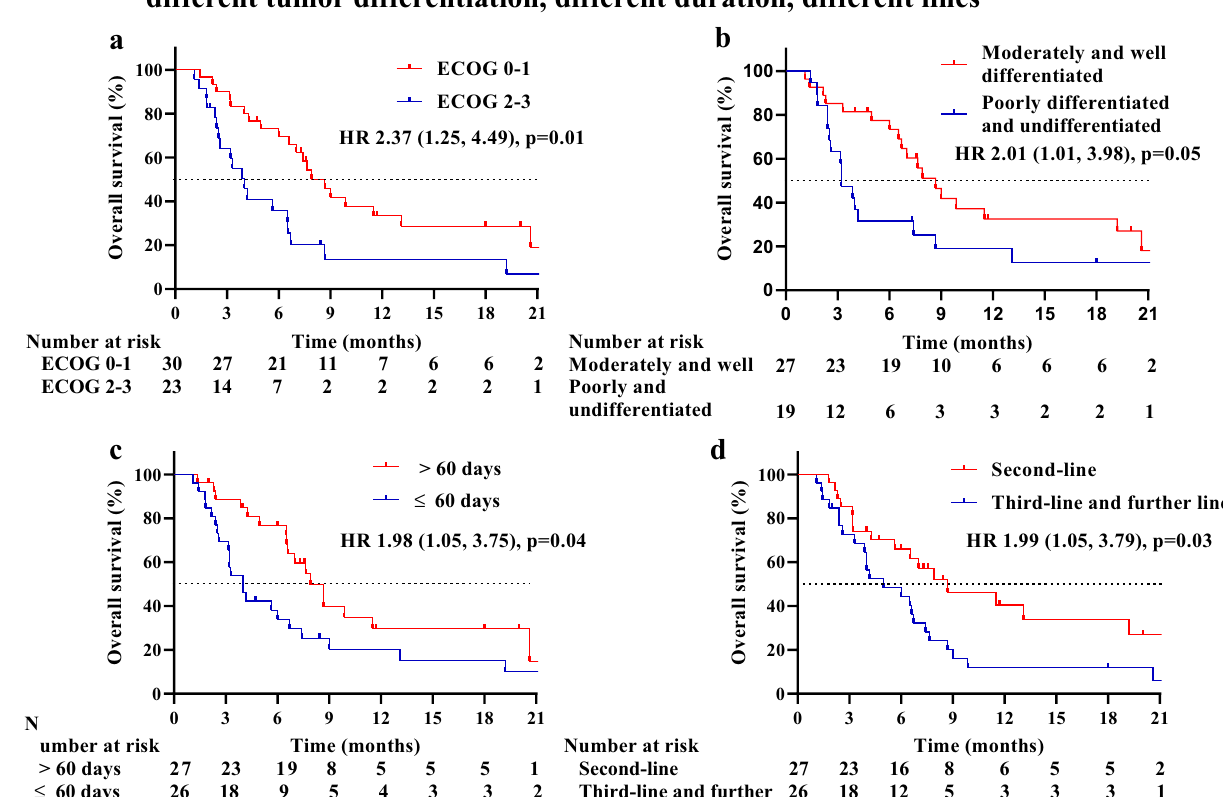
Figure 4. In univariable analysis, ( a ) comparison of OS between patients with an initial ECOG score of 0–1 and an ECOG score of 2–3. The median OS was 8.7 months (95% CI 6.85–10.49) for patients with an initial ECOG score of 0–1 versus 4.0 months (95% CI 2.73–5.27) for patients with an initial ECOG score of 2–3 (p = 0.01). ( b ) Comparison of OS between patients with moderately differentiated and well-differentiated tumors and poorly differentiated and undifferentiated tumors. The median OS was 8.7 months (95% CI 6.68–10.67) for patients with moderately differentiated and well-differentiated tumors versus 3.2 months (95% CI 2.21–4.20) for patients with poorly differentiated and undifferentiated tumors (p = 0.05). ( c ) Comparison of OS between patients treated with apatinib for more than 60 days and within 60 days. The median OS was 7.9 months (95% CI 6.18–9.63) for patients treated with apatinib for more than 60 days versus 4.0 months (95% CI 2.79–5.21) for patients treated with apatinib for within 60 days (p = 0.04). ( d ) Comparison of OS between patients treated with apatinib as the second-line medication with the third-line and further line medication. The median OS was 8.7 months (95% CI 3.08–14.26) for treatment with apatinib as the second-line medication versus 5.0 months (95% CI 1.73–8.21) for treatment with apatinib as the third-line and further line medication (p =